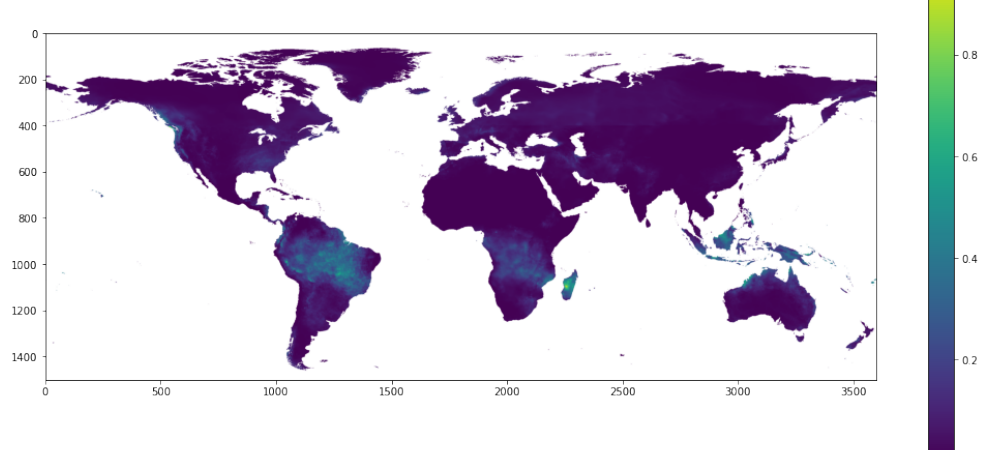
Figure 1. A sample full image of the rainfall dataset used in this research [72]. Color scale indicates normalized rainfall